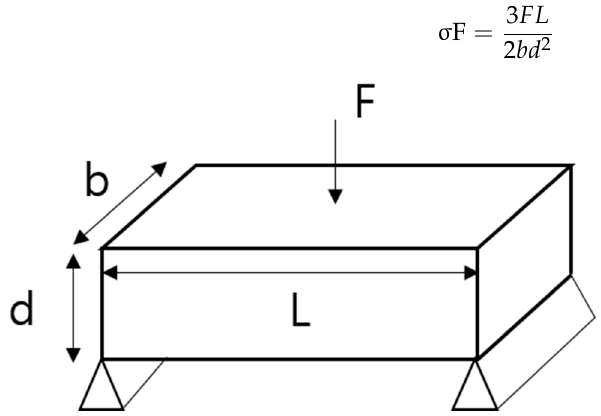
Figure 3. Schematic representation of FS acting on an object.